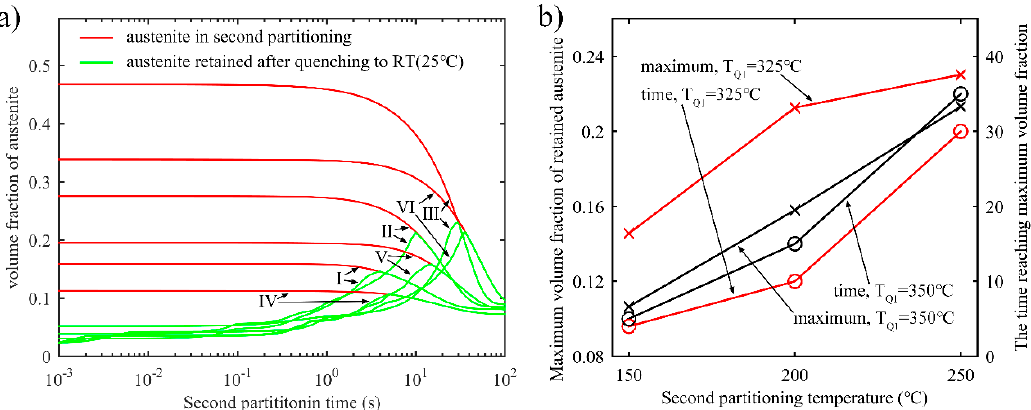
Figure 9. ( a ) Volume fraction of austenite in the second partitioning process and retained austenite after quenching to room temperature as a function of the second partitioning time during the two-stage Q-P process. T P1 = 425 ° C, the first partitioning time is 10 s, T P2 = 350 ° C and the second partitioning time is 100 s. The quenching temperature is: Ⅰ : T Q1 = 325 ° C, T Q2 = 150 ° C; Ⅱ : T Q1 = 325 ° C, T Q2 = 200 ° C; Ⅲ : T Q1 = 325 ° C, T Q2 = 250 ° C; Ⅳ : T Q1 = 350 ° C, T Q2 = 150 ° C; Ⅴ : T Q1 = 350 ° C, T Q2 = 200 ° C; Ⅵ : T Q1 = 350 ° C, T Q2 = 250 ° C; ( b ) Maximum volume fraction of retained austenite and the corresponding partitioning time for reaching the maximum value at different second partitioning temperature.